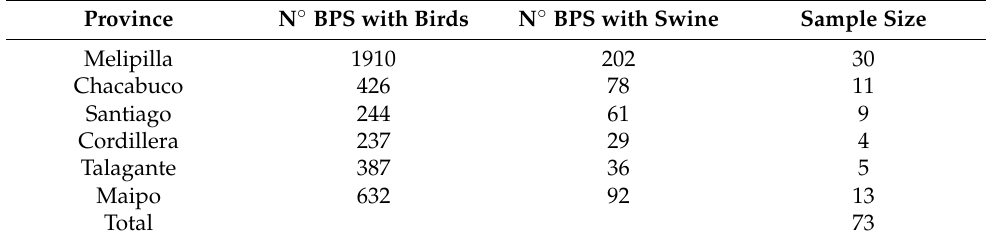
Table 1. Sample size determination by province, Metropolitana